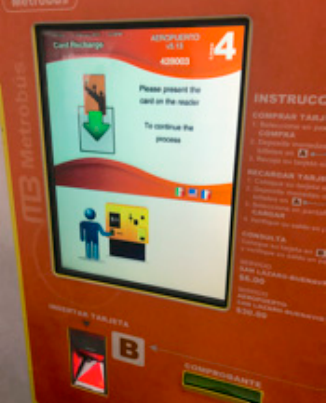
Figure 21. Interface of automated parking meter in commercial shopping center in Cali. The audio speaker is only useful for requesting assistance but does not work as a screen reader for the visually impaired.